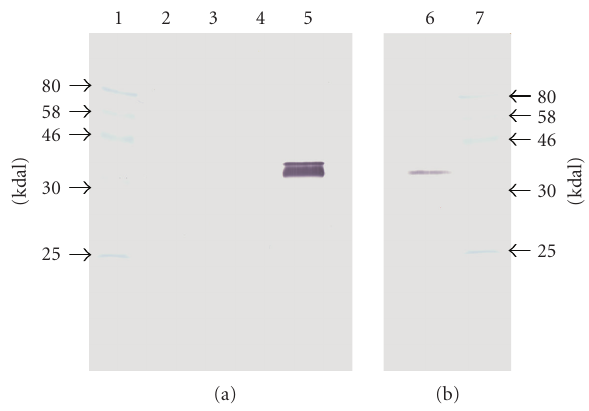
Figure 5: Demonstration of TcoMSP-D in whole cell lysates of T. congolense and in cell-free serum of infected mice. Cell-free serum (equivalent to 0.2 μ L of undiluted serum) from control and infected mice and T. congolense whole cell lysates were separated by SDS PAGE and transferred to nylon membrane for Western analysis. The membrane was probed with rabbit α -TcoMSP-D (NH3 domain) at 1/500 dilution and visualized with goat α -rabbit HRP conjugated secondary antibody at 1/500 dilution. Lane 1: molecular weight standards; lane 2: normal mouse serum; lane 3: serum from T. congolense -infected mouse at 3 days post infection; lane 4: empty lane; lane 5: serum from T. congolense -infected mouse at 6 days post infection; lane 6: lysate from equivalent of 5 million blood-form T. congolense parasites; lane 7: molecular weight